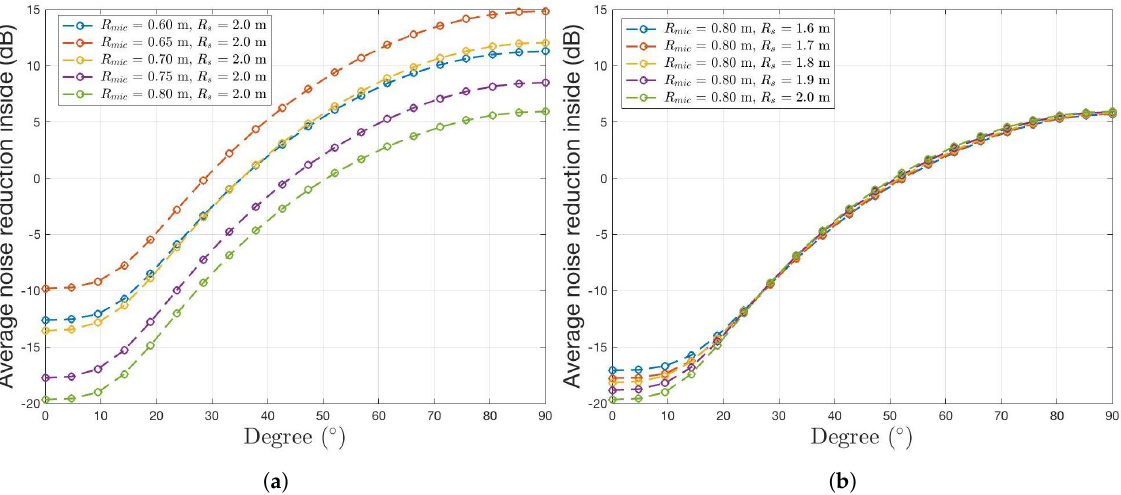
Figure 9. Average noise reduction with respect to the noise source angle. According to the change of R mic ( a ) and R s ( b ).